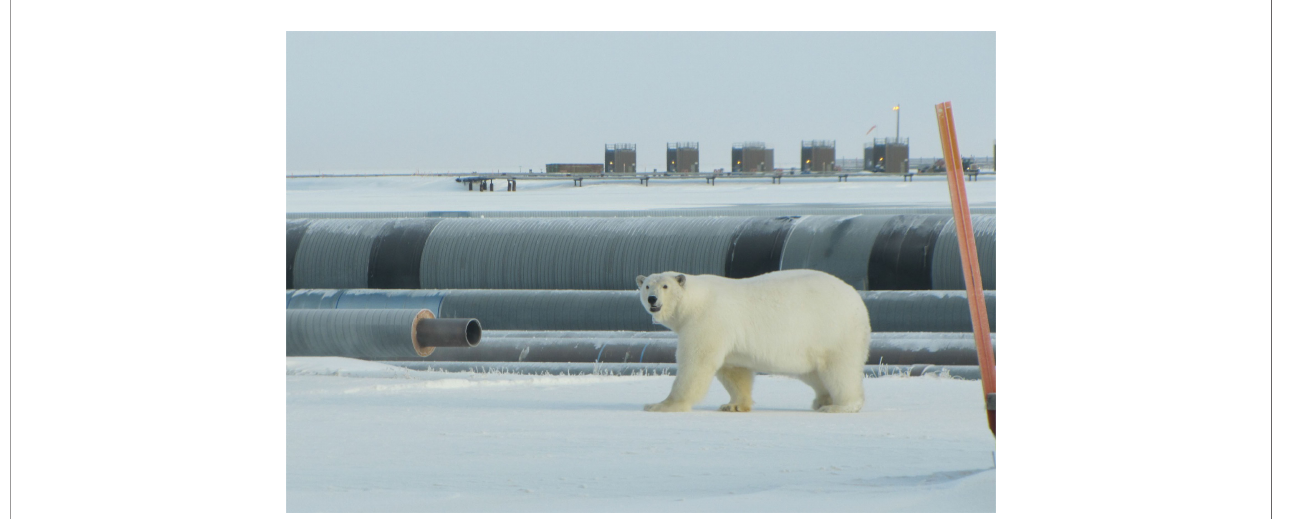
FIGURE 8 | A polar bear walking through oil fi eld infrastructure near Prudhoe Bay on the Arctic coastal plain of Alaska, which is home to a large industrial footprint. Photo credit: BP Exploration (Alaska), Inc., with